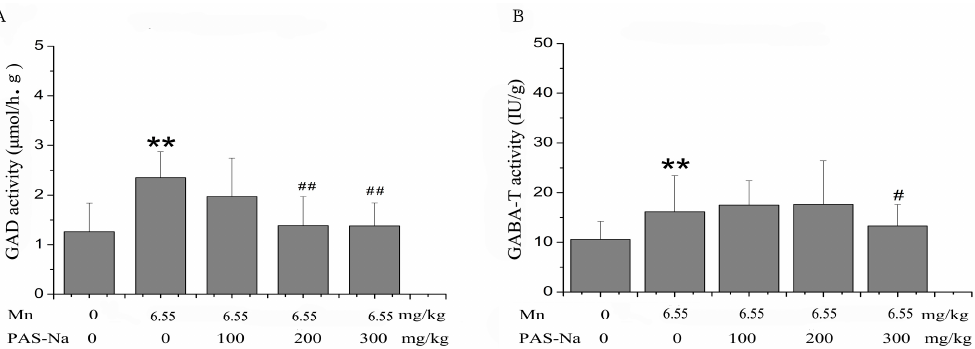
Figure 4. PAS-Na attenuated the increase of GAD and GABA-T activity in the basal ganglia of Mn-exposed rats. ( A ) GAD activity; ( B ) GABA-T activity. Data represent mean ± SD. N = 5 per group. ** p < 0.01: significant as compared to control; # p < 0.05 or ## p < 0.01: significant as compared to Mn-treated group.